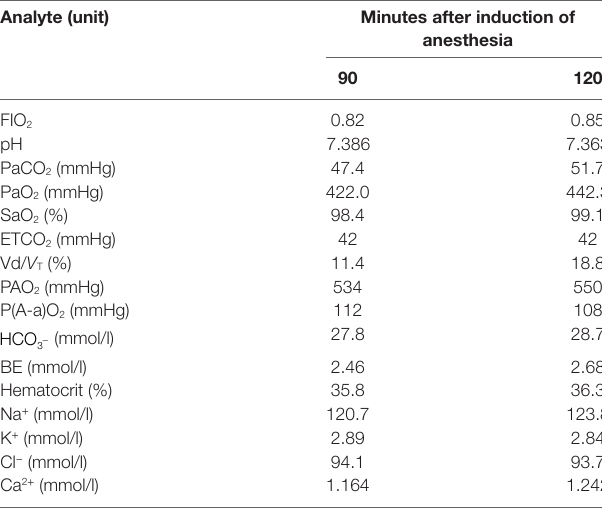
table 1 | Oxygenation, arterial blood gas parameters, and plasma electrolyte concentrations of a 12-year-old male pony under isoflurane anesthesia with volume-controlled ventilation through a nasotracheal tube.